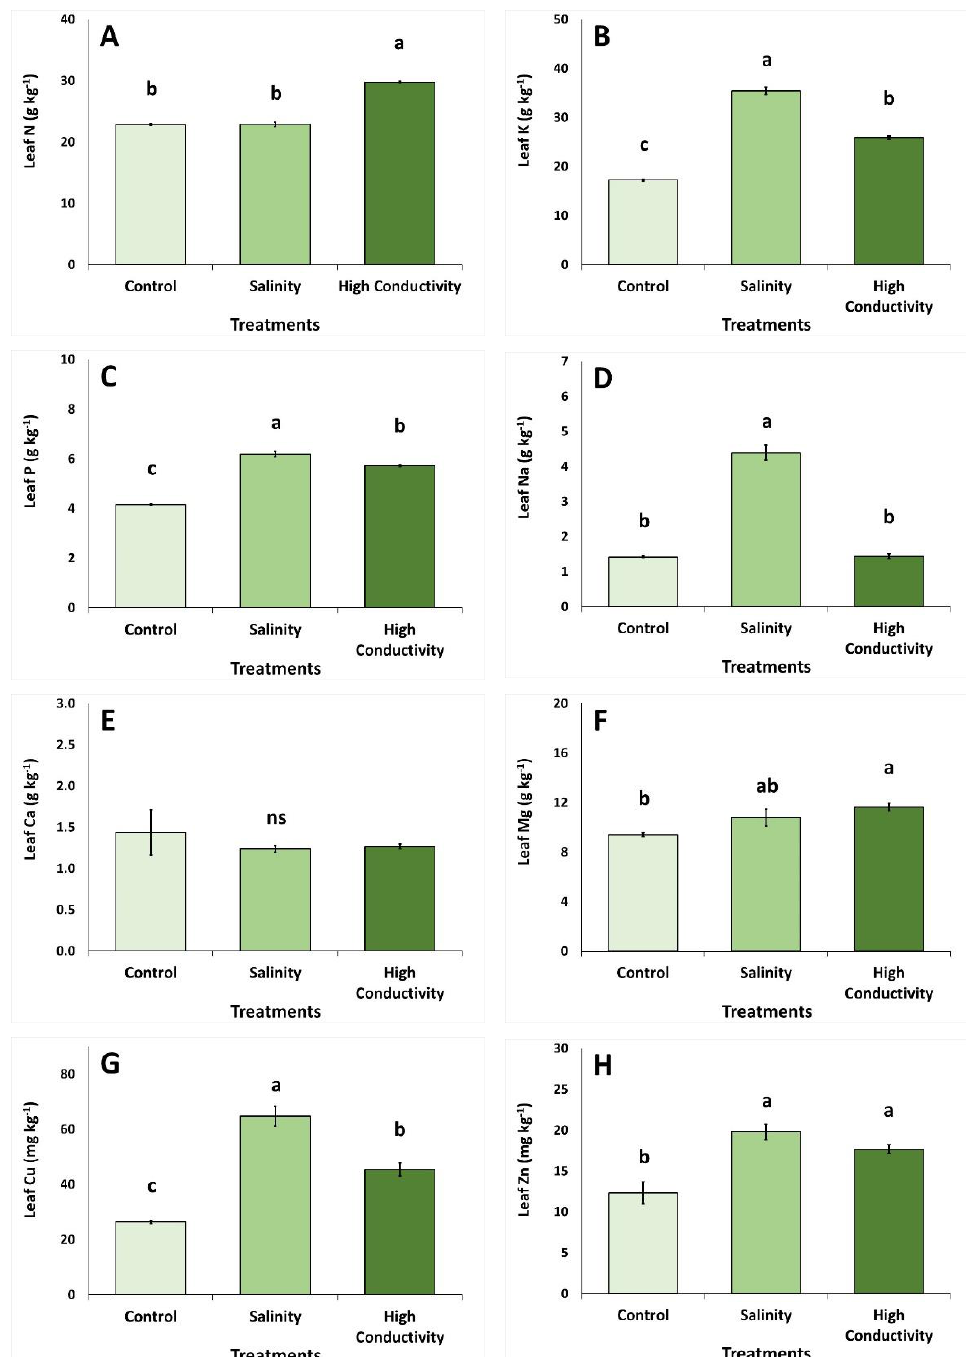
Figure 5. Influence of salinity (75 mM NaCl) and high conductivity (8.5 dS m − 1 ) on the leaf content of macro- and micronu- trients on verbena plants grown hydroponically in perlite substrate. ( A ) nitrogen—N, ( B ) potassium—K, ( C ) phosphorus—P, ( D ) sodium—Na, ( E ) calcium—Ca, ( F ) magnesium—Mg, ( G ) copper—Cu and ( H ) zinc—Zn. Significant differences ( p < 0.05) are indicated by different letters above each bar. Error bars show SE (n = 4).